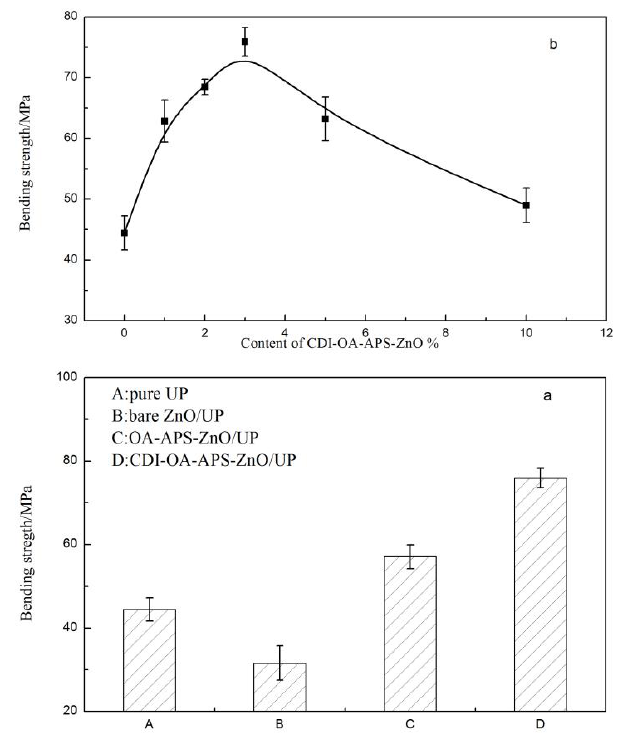
Figure 10. Bending strength profiles of UP composite films with ( a ) different kinds of ZnO nanoparticles and ( b ) different